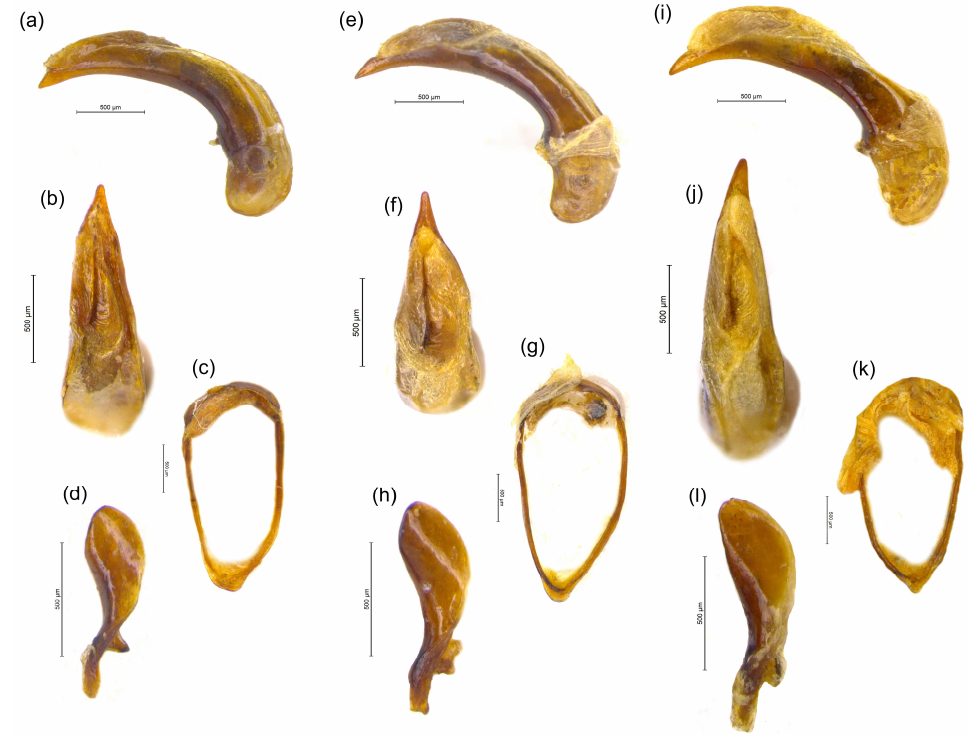
Figure 11. Male genitalia: The median lobe of the aedeagus is in lateral and dorsal view, IX invaginated segment and right paramere of: ( a – d ) P. depressus ; ( e – h ) P. vignai n. sp .; ( i – l ) P. teriolensis